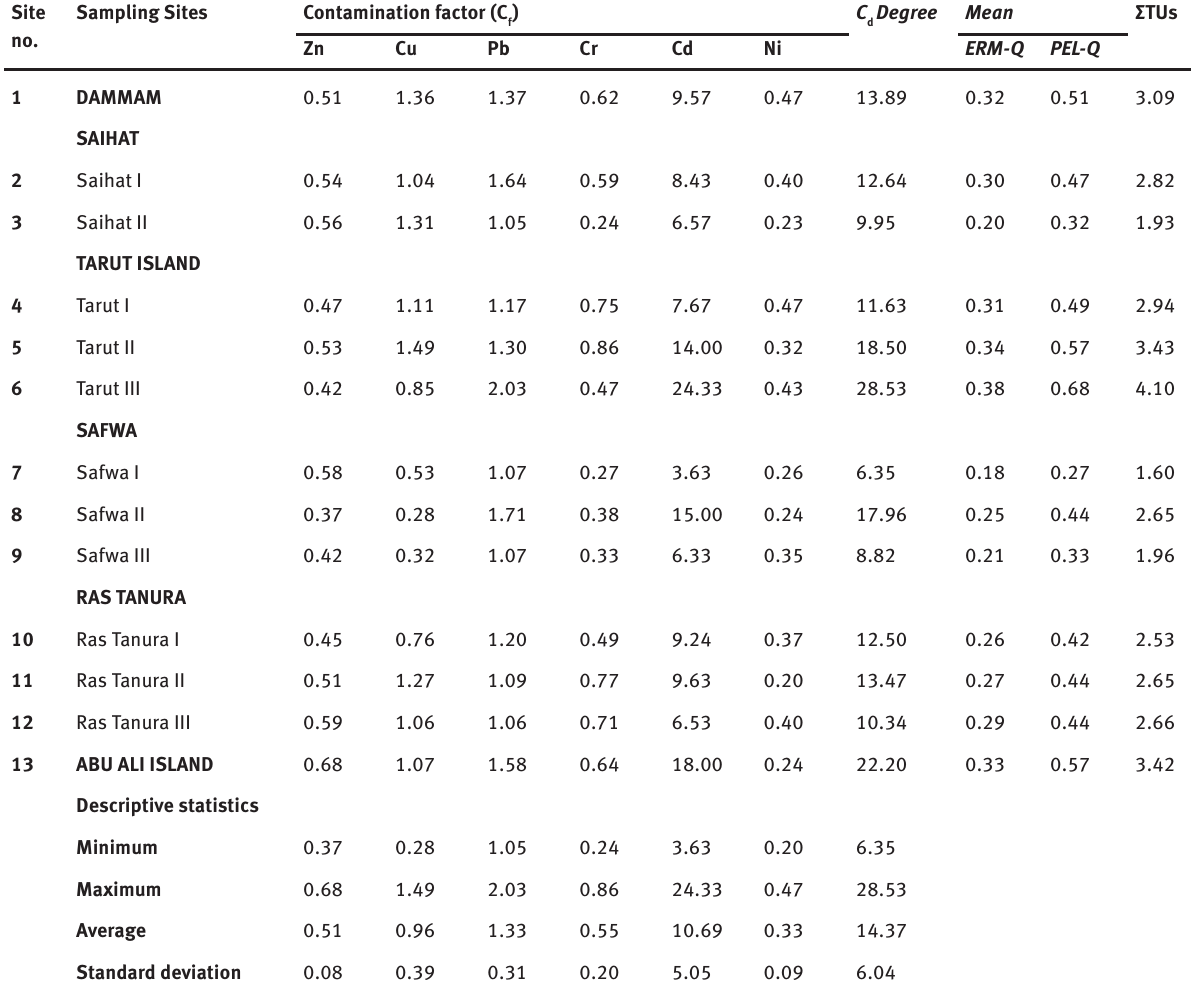
Table 6: Contamination factor of trace elements and Mean ERM in surface sediments in the study area. Site Sampling no.